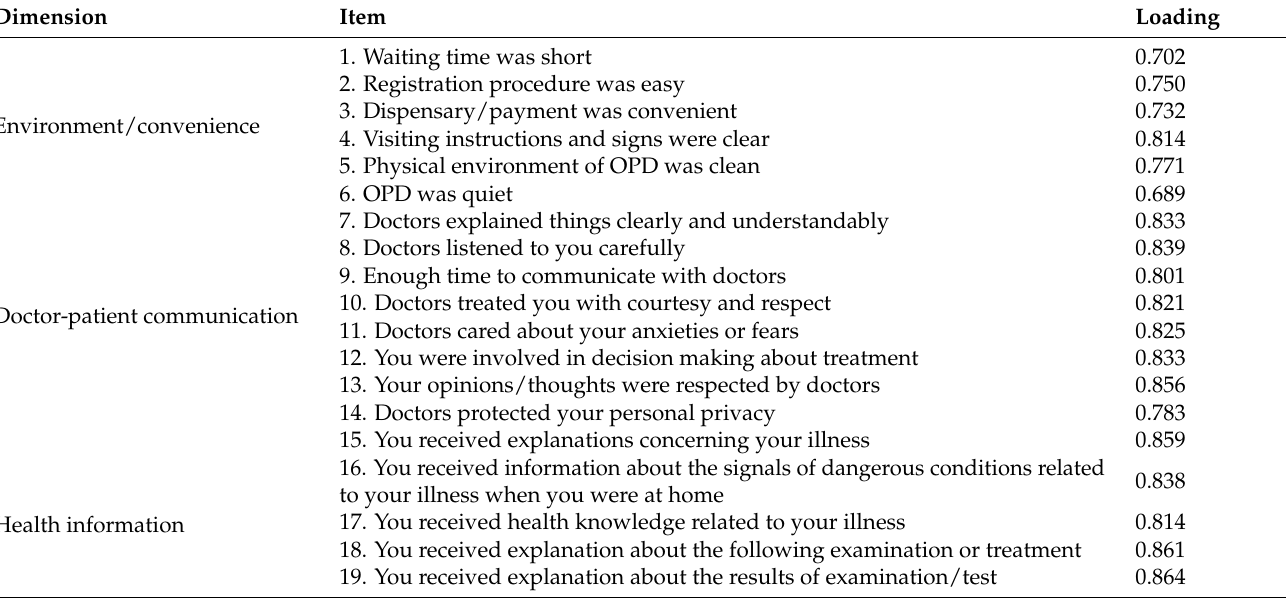
Table 3. Items of client satisfaction and factor loadings by confirmatory factor